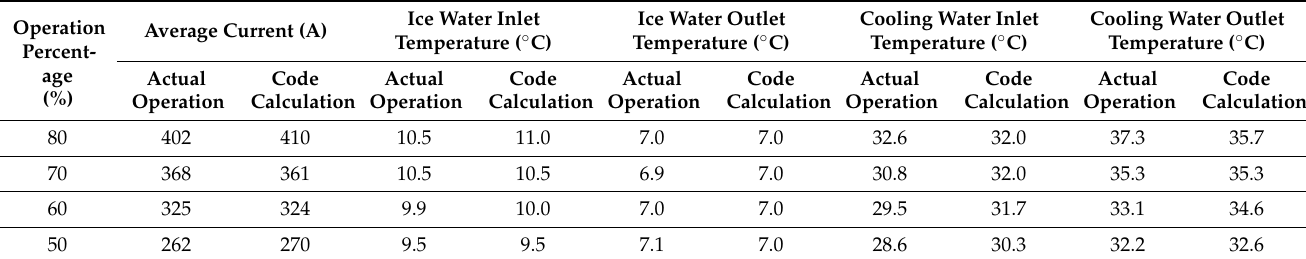
Table 7. Comparison between actual chiller on-site operation and the commercial consumer code program operation mode. Operation Percent- age